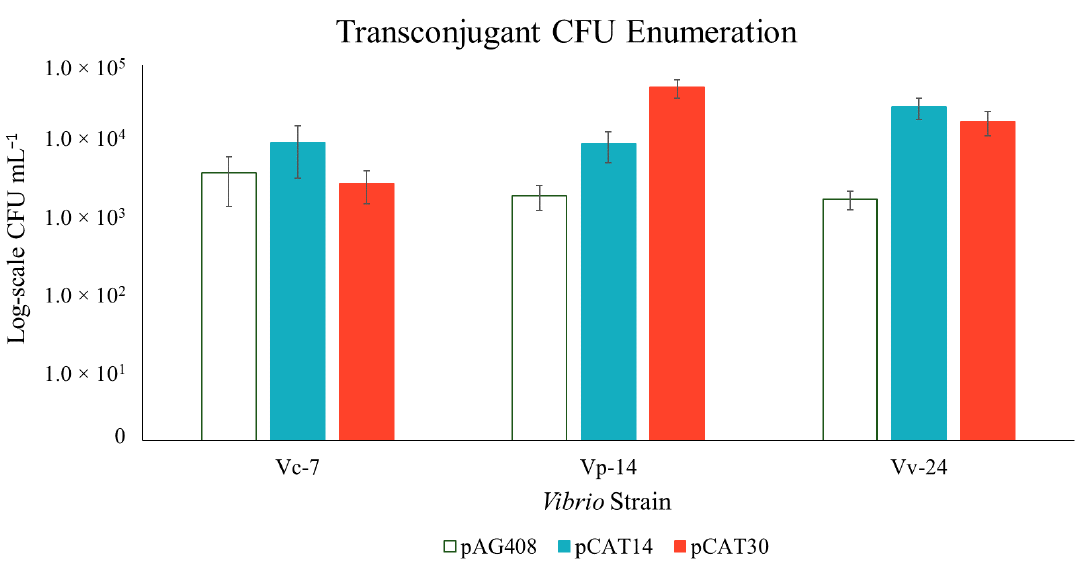
Figure 2. Transconjugant enumeration of Vibrio strains labeled with pAG408 (white), pCAT14 (blue), and pCAT30 (red). The labelling ability of the three suicide vectors were tested against three representative V. cholerae (Vc), V. parahaemolyticus (Vp), and V. vulnificus (Vv) strains. Error bars represent the standard deviation between triplicates. Transconjugant enumeration was done on MB agar supplemented with Gm (50 µ g mL − 1